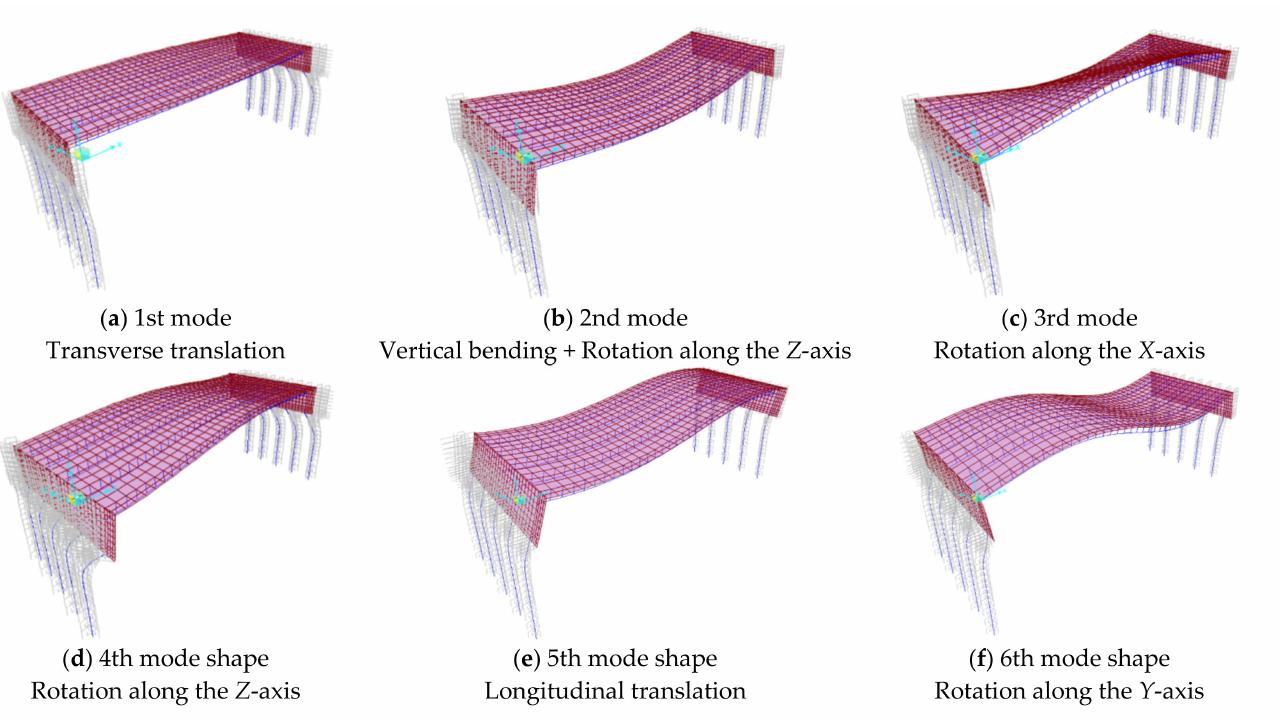
Figure 4. Mode shapes of Model